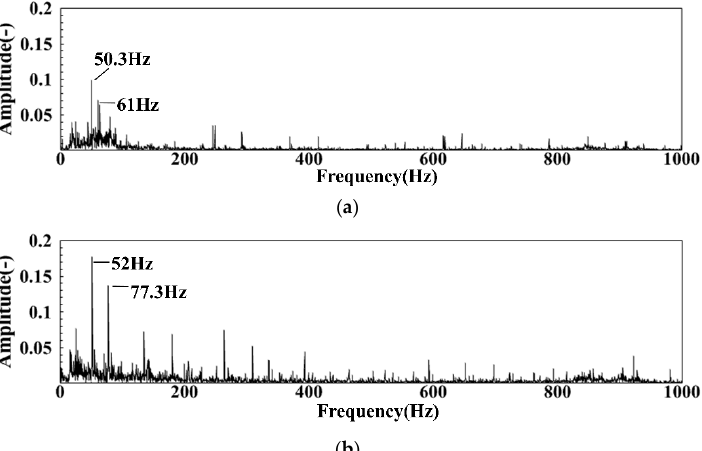
Figure 21. The DP spectrum of cold state under different air intakes: ( a ) The spectrum of cold DP in group LB; ( b ) The spectrum of cold DP in group LC.